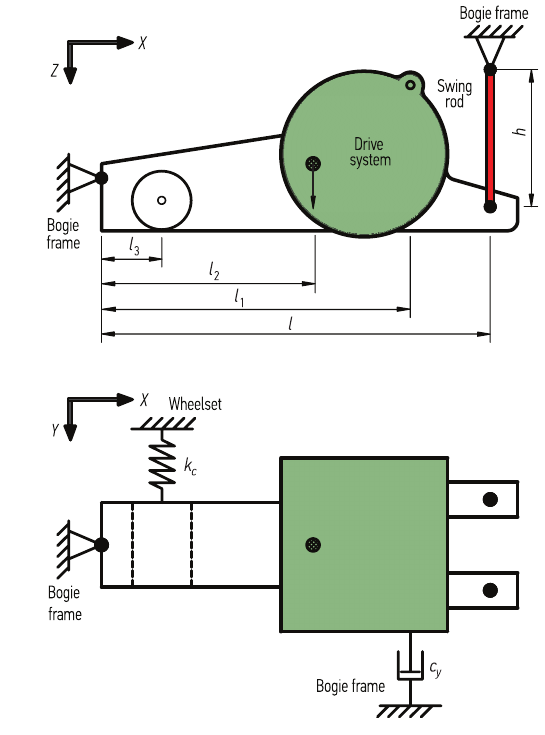
Fig. 16. The flexible suspension drive system A